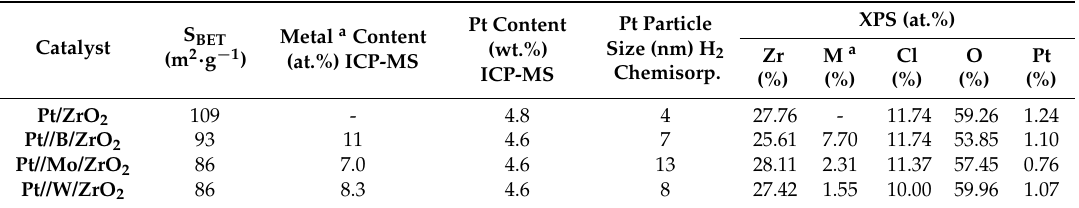
Table 1. Some features concerning the characterization of the different supported Pt catalysts. Brunnauer–Emmett–Teller (BET) surface area, Pt particle size (H 2 chemisorption) and catalyst chemical composition (as determined by X-ray photoelectron spectroscopy (XPS) and inductively coupled plasma with mass spectrometry detection